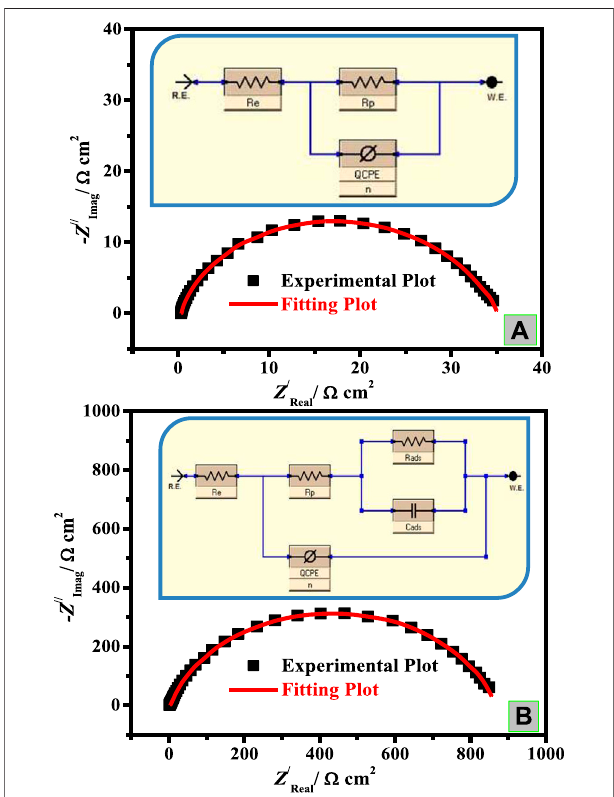
FIGURE 4 | Comparison of experimental Nyquist and Bode phase data (points) and fi tted data (line) measured for C-steel in blank (A) and inhibited systems (B) . Inset: EEC for C-steel/CO 2 -saturated 3.5% NaCl/surfactant uninhibited (A) and inhibited (B)